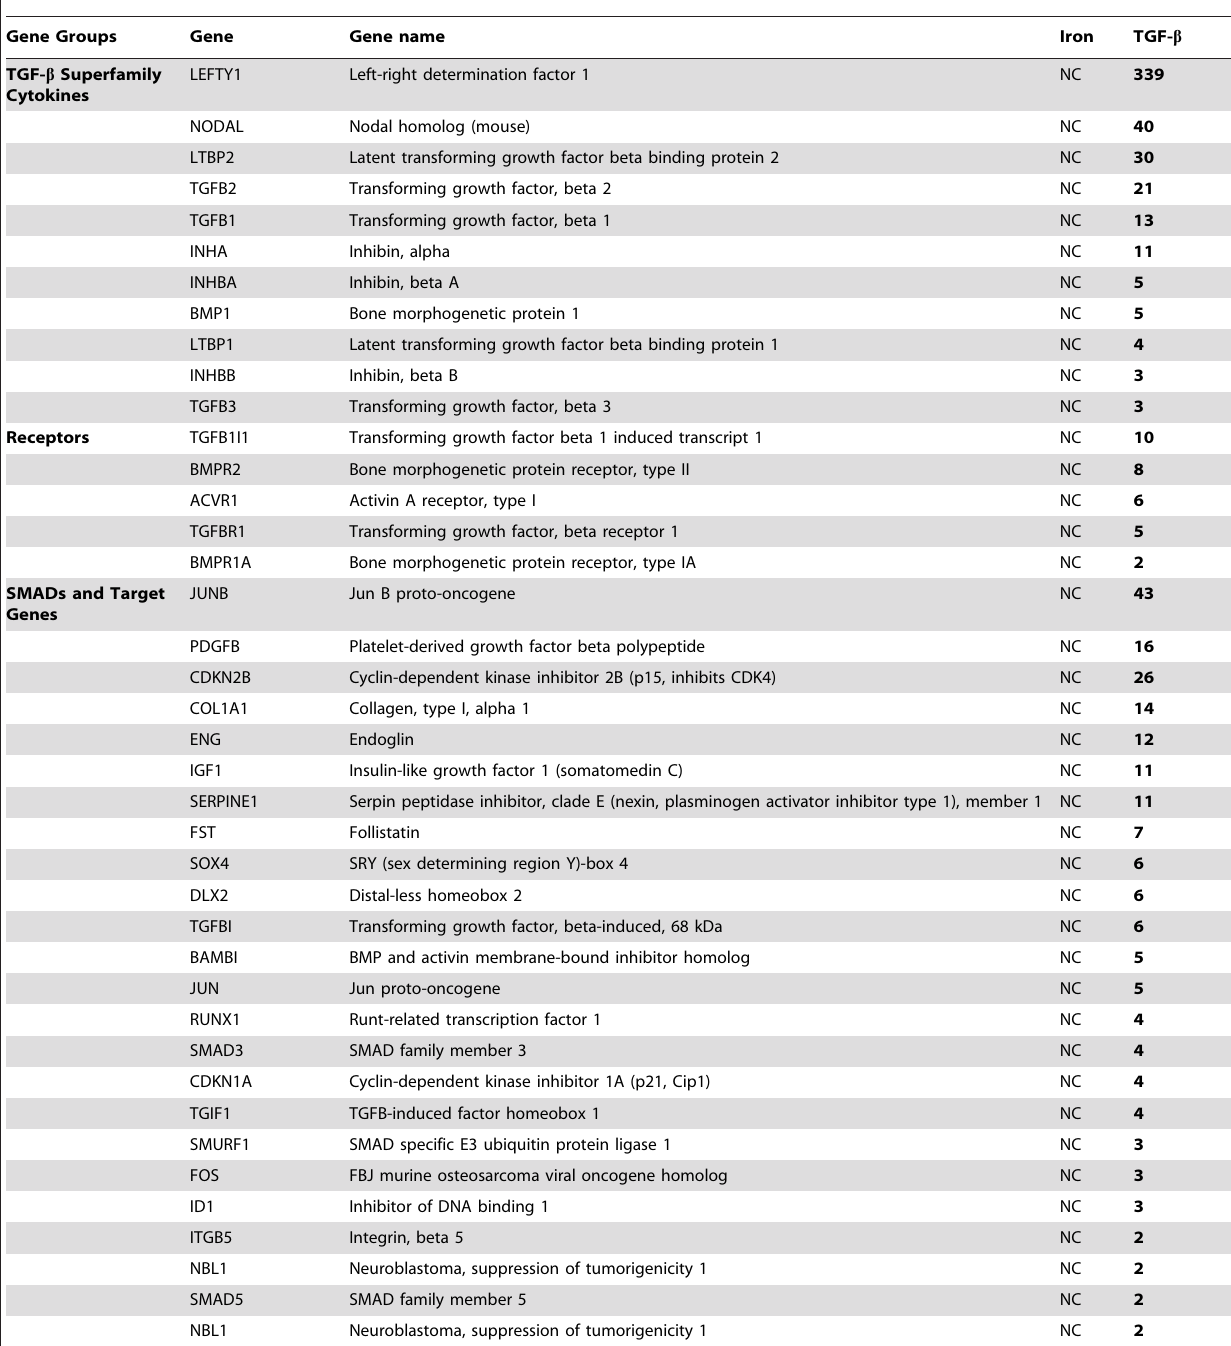
Table 1. Fold increase in TGF- b /BMP pathway gene expression versus untreated cells (NC= no change).